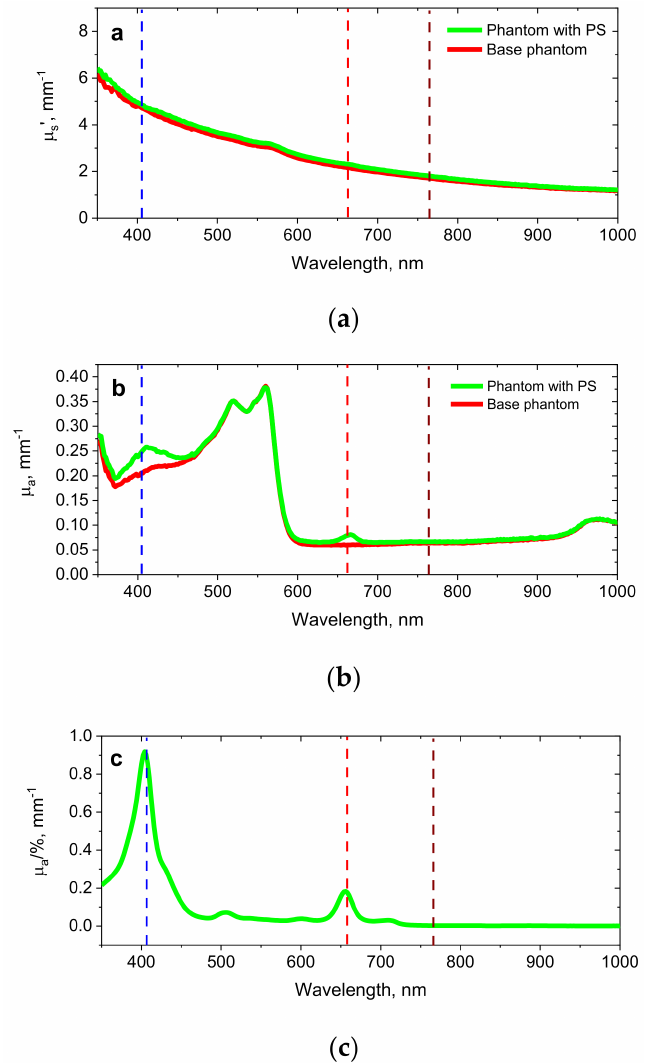
Figure 3. Reconstructed spectra of the reduced scattering ( a ) and absorption ( b ) coefficients of the base tissue phantom and the phantom with PS, and the absorption spectrum of the water- based photosensitizer gel Revixan Derma dissolved in purified water ( c ). Dashed lines show the fluorescence excitation (405 nm, 660 nm) and emission detection (760 nm)